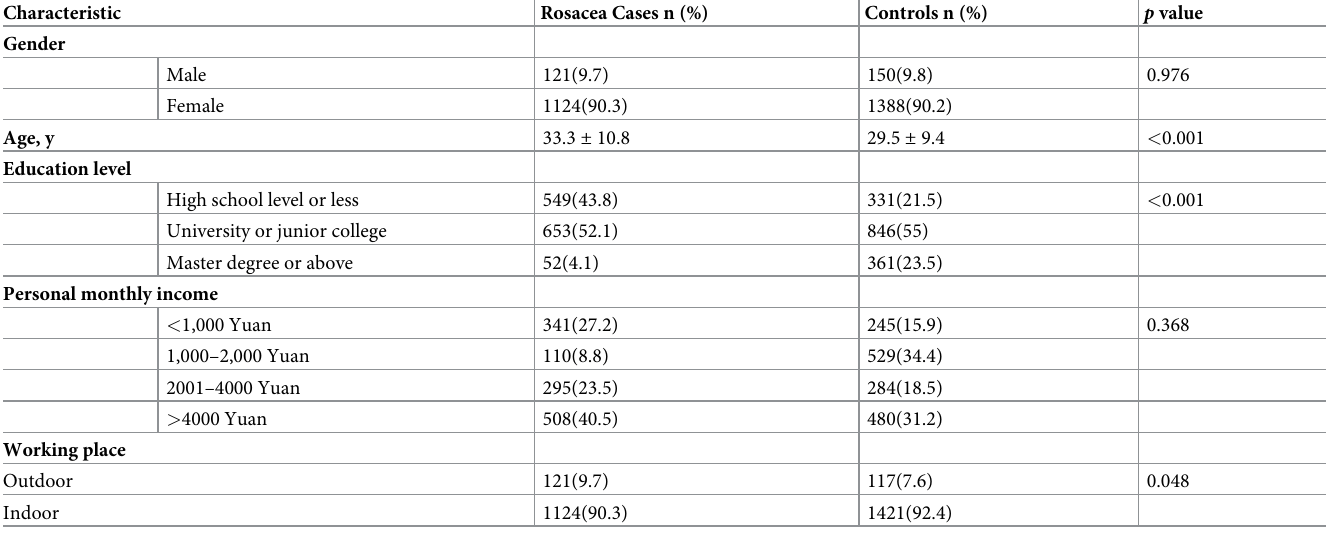
Table 1. Comparisons of demographic characteristics between the case and control